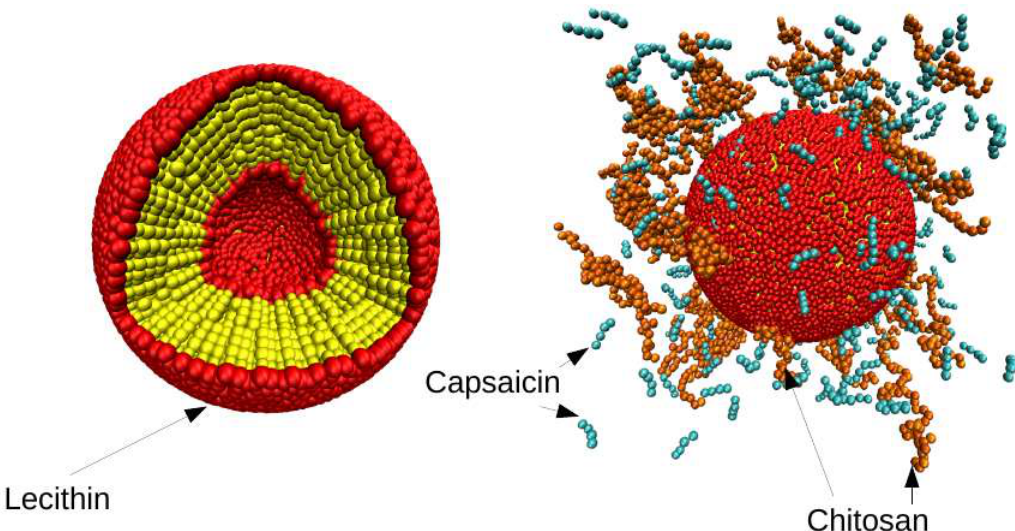
Figure 2. Initial configuration of nanoliposome. A snapshot of the initial configuration of lecithin molecules in the structure of a liposome bilayer ( left ). The yellow spheres represent the hydrophobic part of the lecithin, while the red spheres represent the hydrophilic part. The capsaicin and CS molecules were placed in a random configuration around the lecithin ( right ). The orange chains represent the CS polymers, while the turquoise chains represent the capsaicin molecules. These Figures were prepared with the VMD package [53].